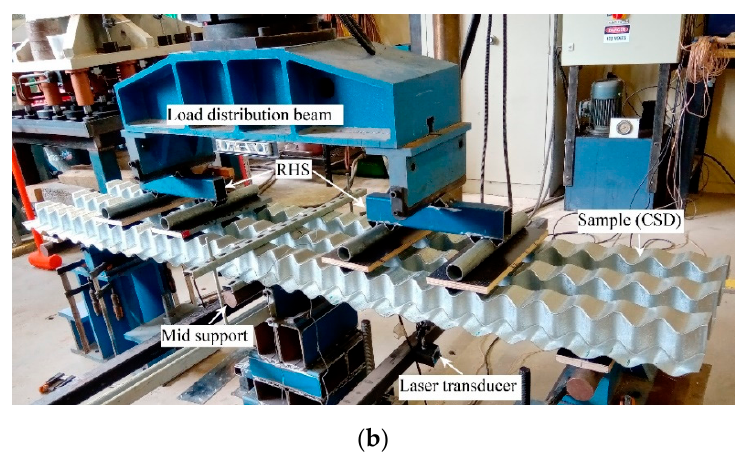
Figure 9. Details of the experimental test of continuous span multiple hat sections: ( a ) test arrangement for the continuous span test; and ( b ) continuous span test.